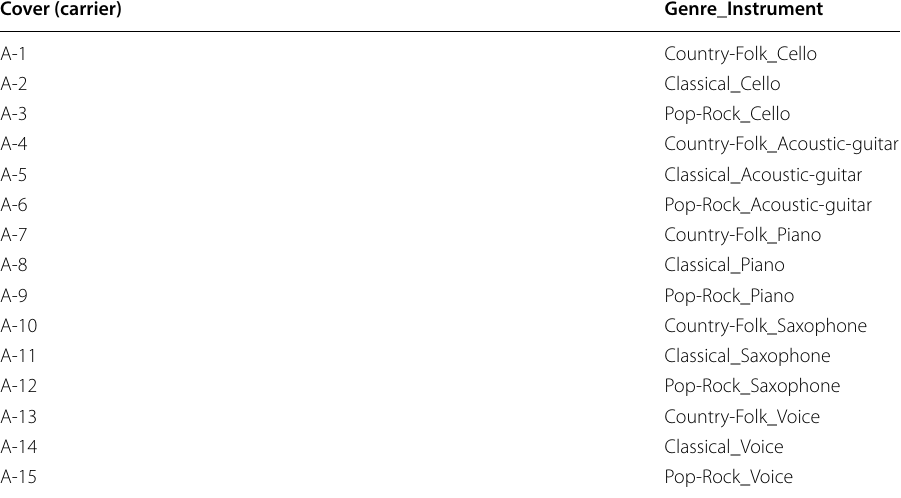
Table 2 Various instruments and genres of the audio cover for evaluating the methods [36, 37] Cover (carrier)